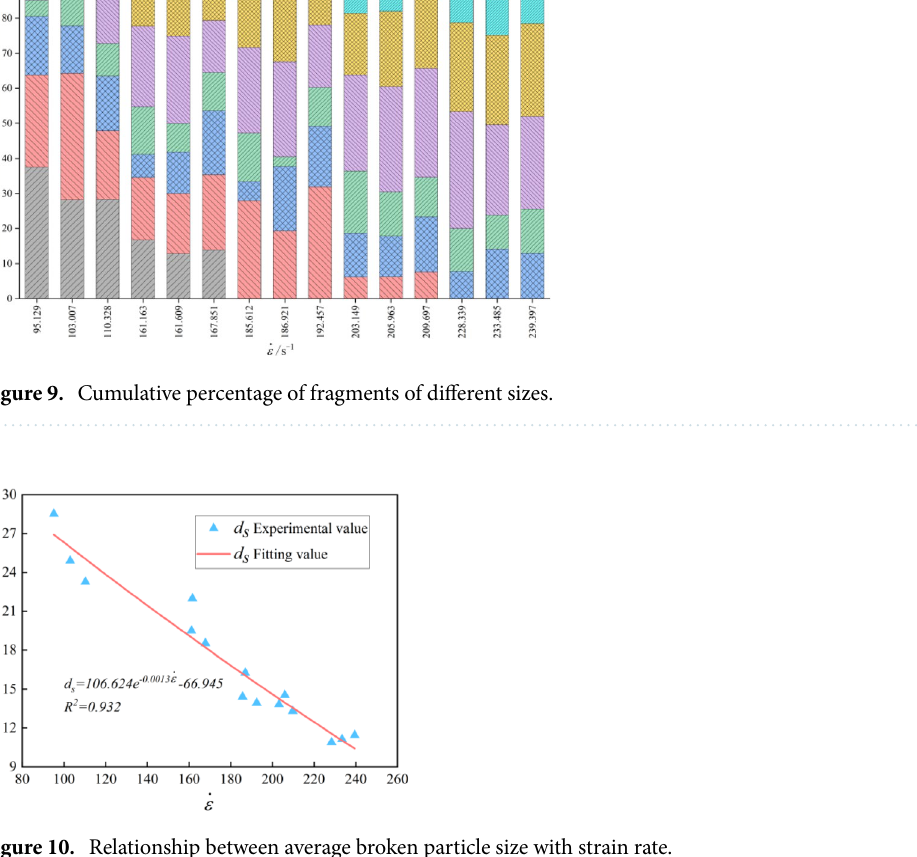
Figure 10. Relationship between average broken particle size with strain rate.